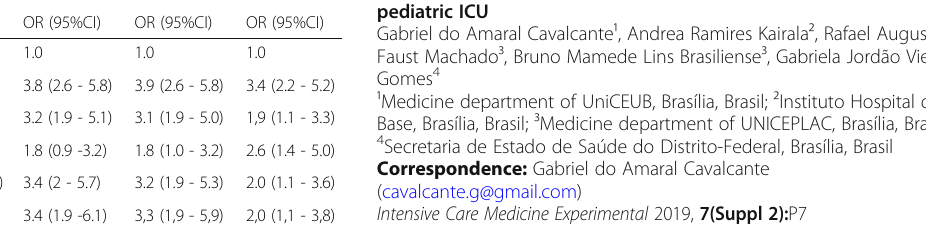
Table 1 (abstract P5). Hierarchical Logistic regression and mortality Site of